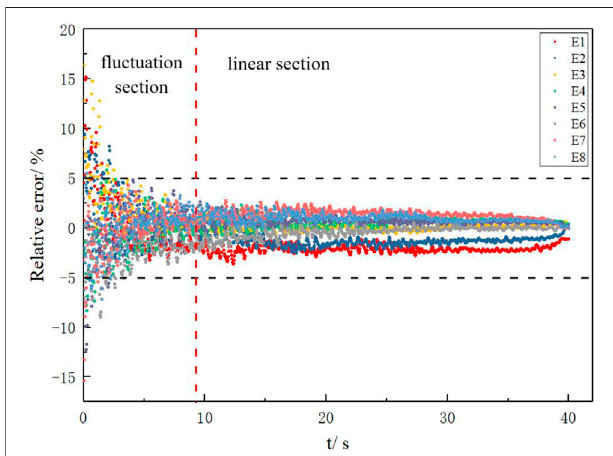
FIGURE 2 | Error analysis of mass fl ow rate in repeated experiment ( D o (cid:1) 30 mm , D p (cid:1) 6 mm ).